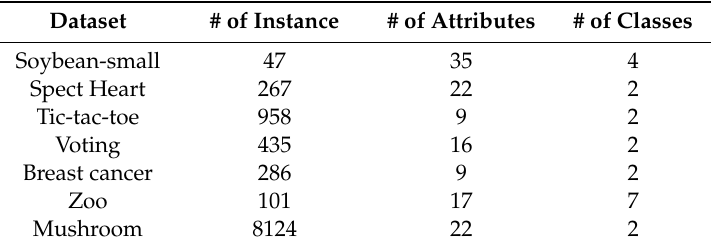
Table 1. Benchmark